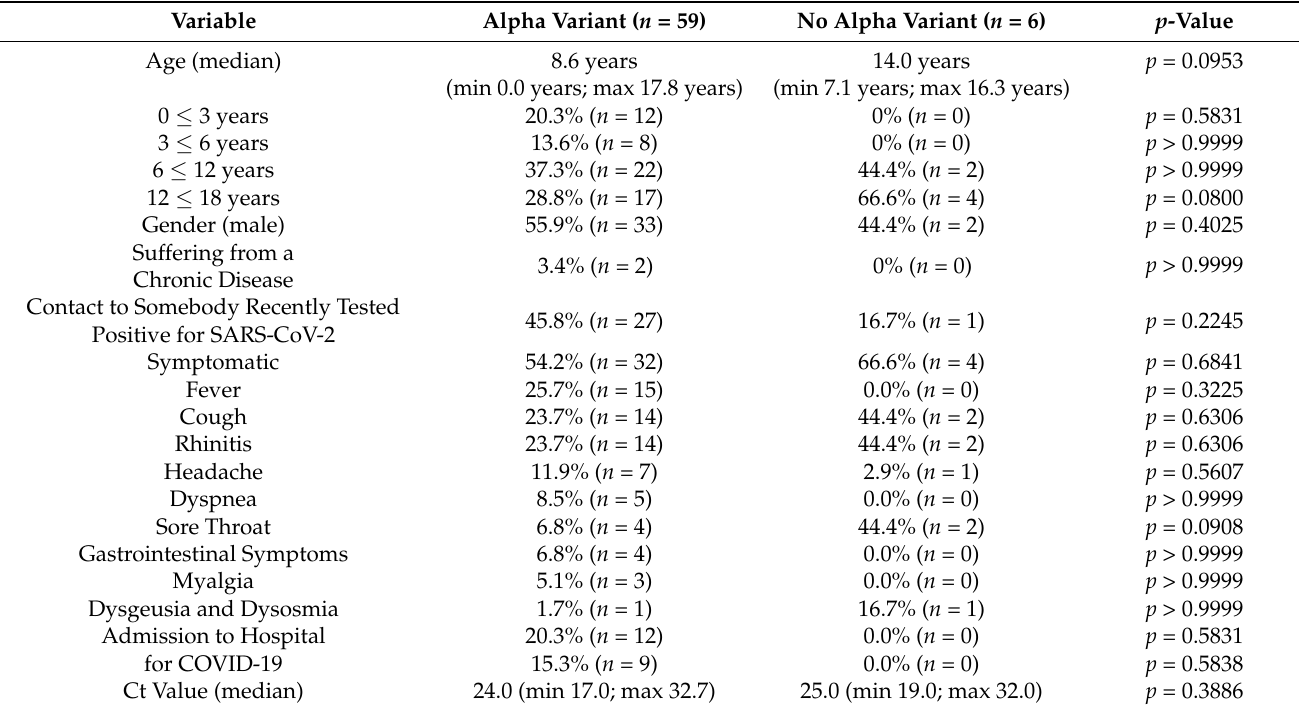
Table 3. Patients tested positive for the Alpha variant ( n = 59) vs. patients tested negative for the Alpha variant ( n = 6).